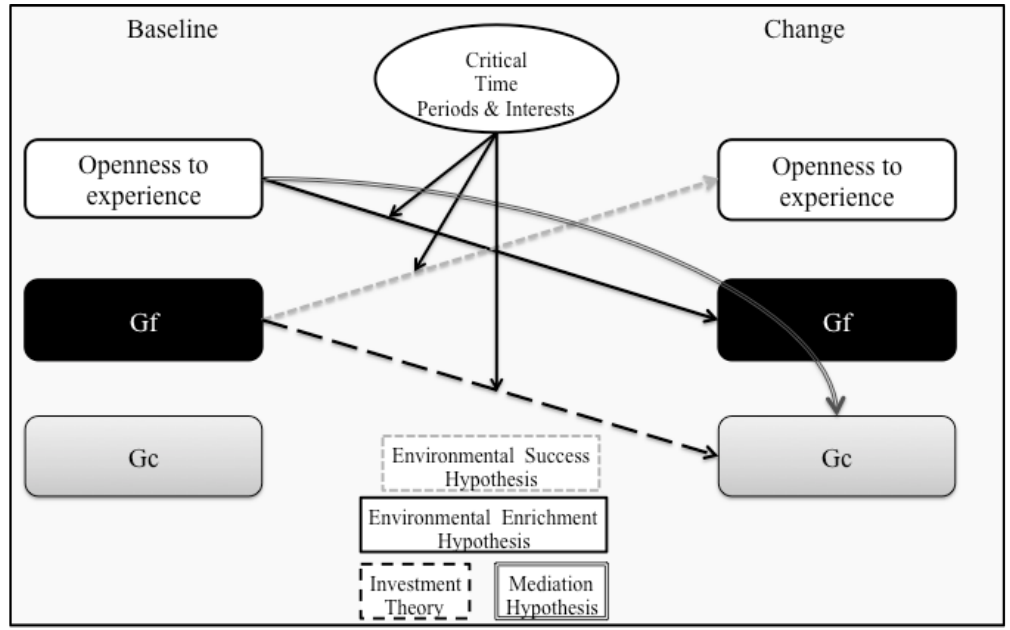
Figure 1. The Openness-Fluid-Crystallized-Intelligence (OFCI) model according to Ziegler, Danay, Heene, Asendorpf and Bühner [12].